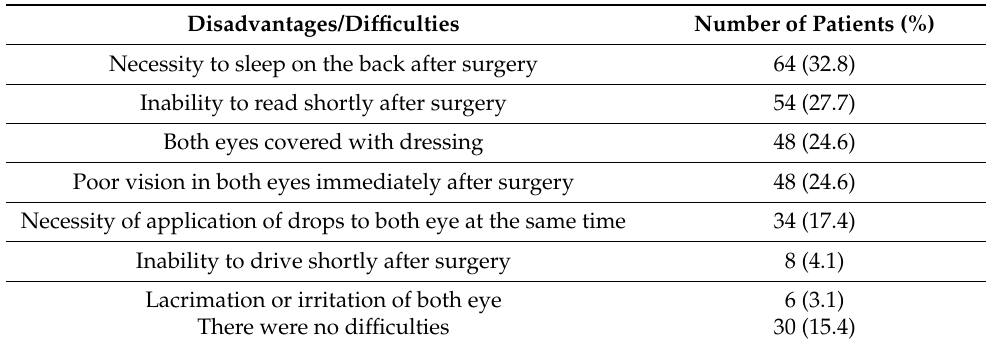
Table 3. Patients’ opinions about disadvantages and difficulties related to immediate sequential bilateral cataract surgery (listed by